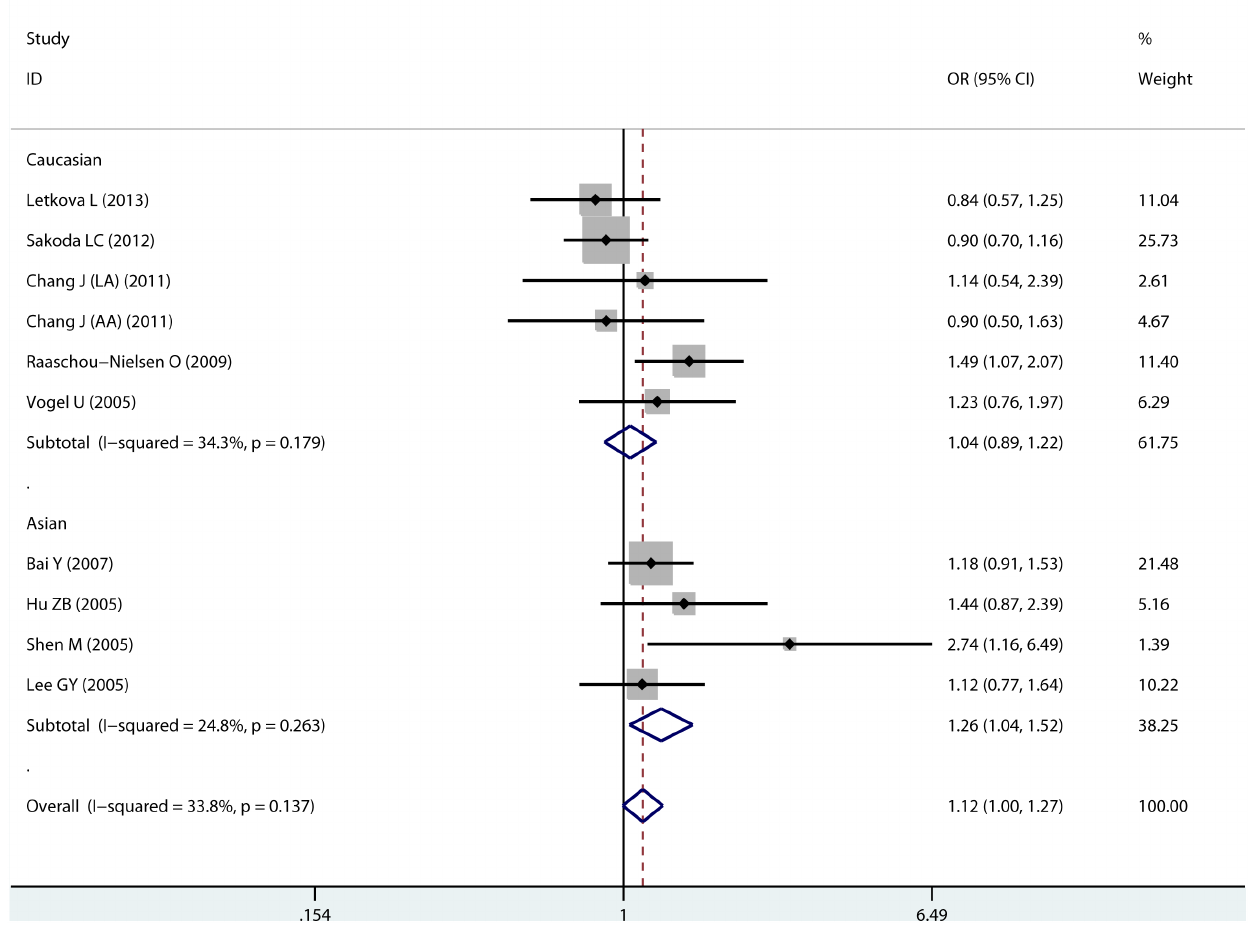
Figure 2. Forrest plot of XPC Lys939Gln polymorphism (GlnGln vs. LysLys/LysGln) by ethnicity.